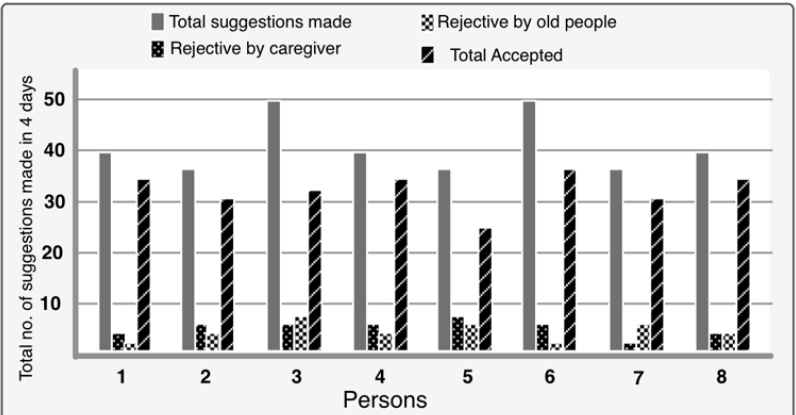
Figure 9. Performance of the suggestion